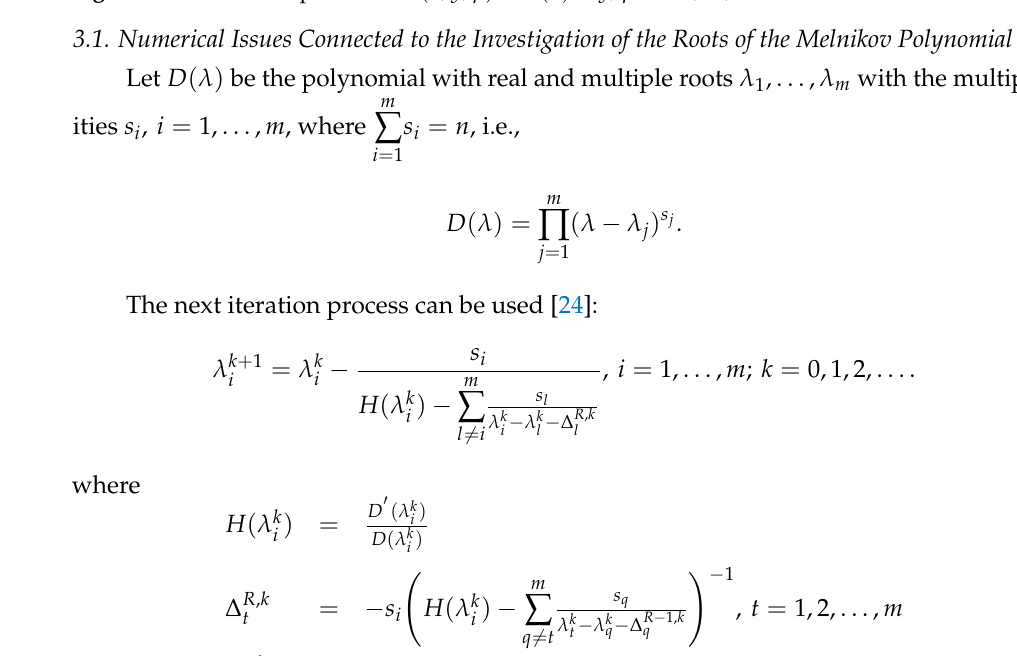
Figure 18. The catastrophe surface ( x , y , p ) = F ( x ) − y ; p =